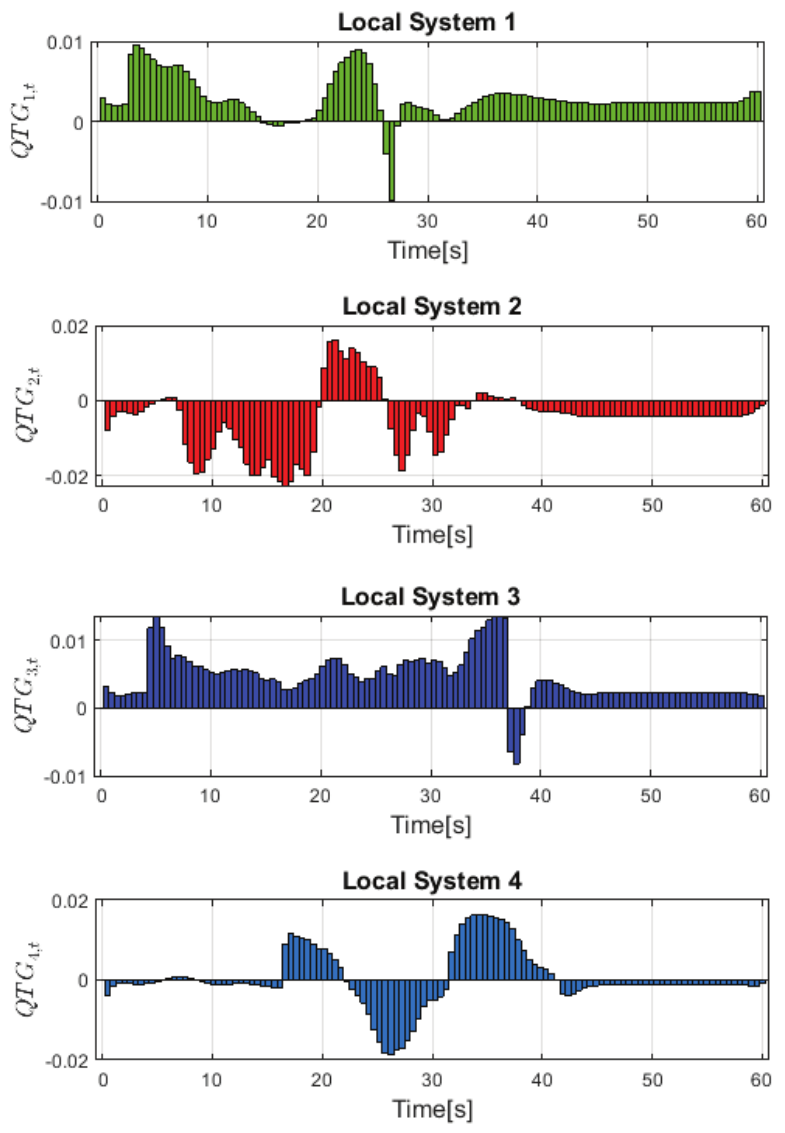
Figure 10. Optimal reactive power at each local system.